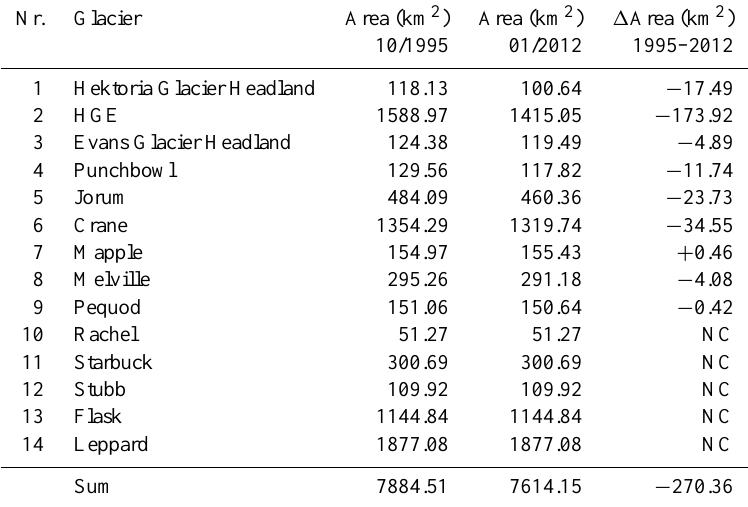
Table 1. Area of glacier basins (in km 2 ) shown in Fig. 1 above the October 1995 grounding line and updated for glacier fronts on 12 January 2012, and change of glacier area 1995 to 2012. NC – no significant change of front position or grounding line. The areas of glacier basins include rock outcrops and mountain